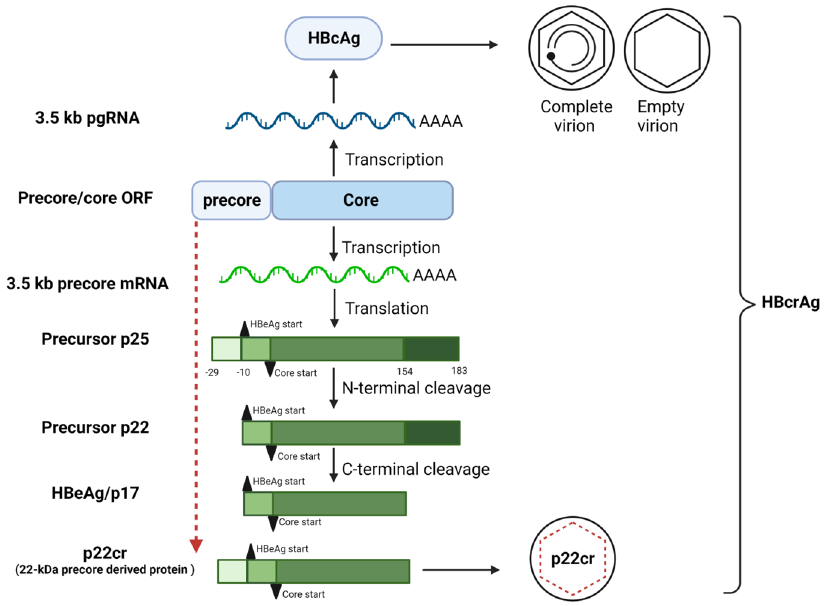
Figure 2. Biogenesis of HBeAg and its precursors. HBeAg and HBcAg translations from the pre- Core/Core ORF, adapted with permission from [50], © 2021 American Society for Microbiology. Image created using biorender.com.